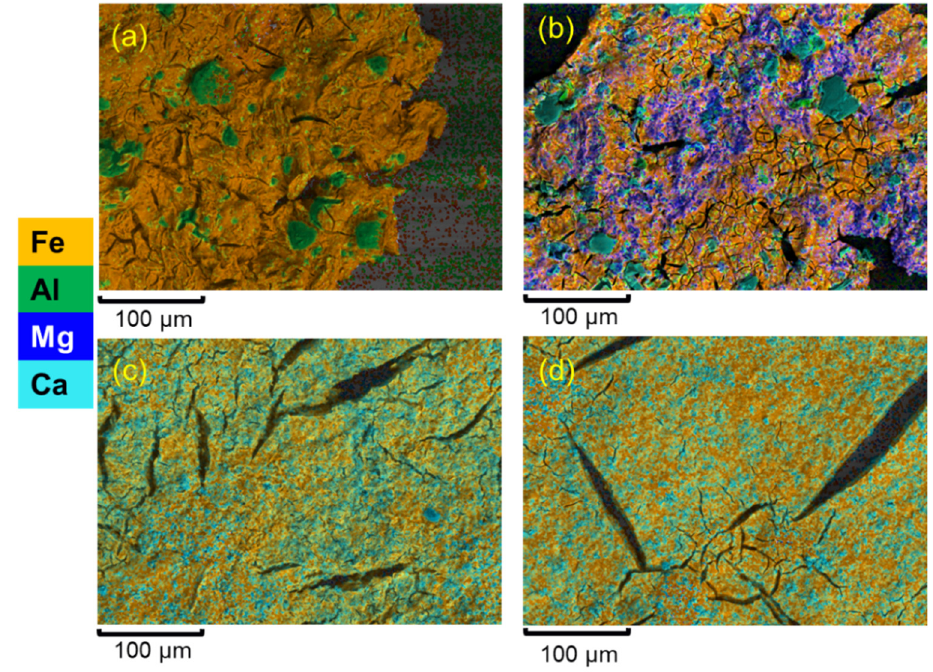
Figure 11. SEM-EDX images of coagulated ( a ) modified bentonite, ( b ) talc and ( c ) calcium carbonate from batch reactor tests, as well as ( d ) calcium carbonate samples from the ATR.